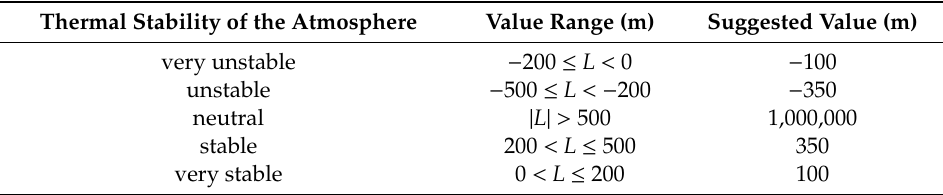
Table A3. Suggested values of the Obukhov length, L